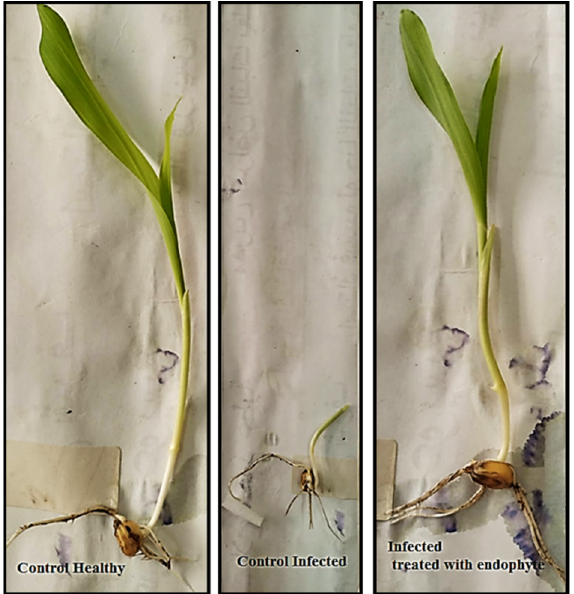
Figure 6. Growth characteristics of corn seedlings in different treatments: control healthy, control infected and infected treated with endophytic fungus A. fumigatus.